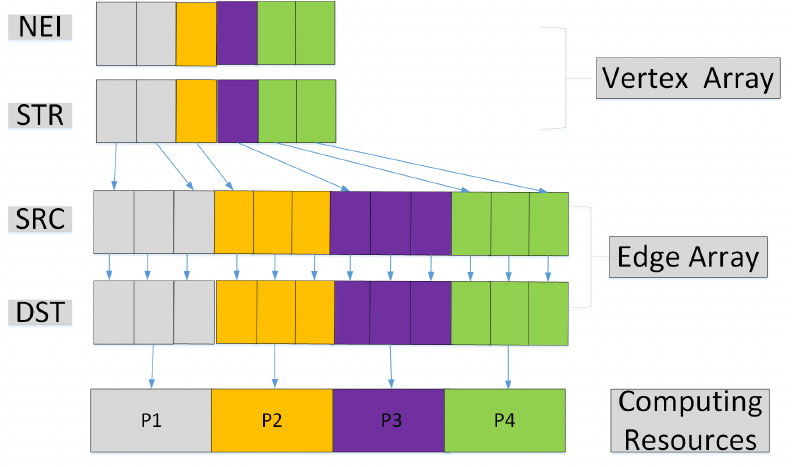
Figure 3. Edge based Sparse Graph